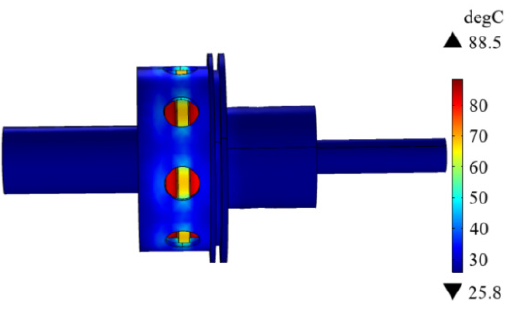
Figure 17. Clutch temperature field simulation results.